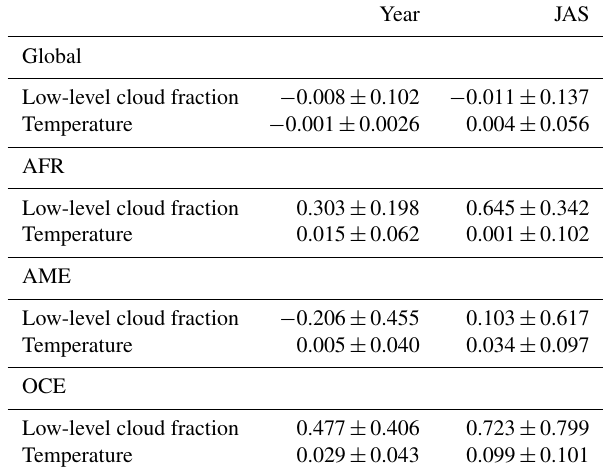
Table 7. Annual and JAS averages ± 2 σ (significance level of 95%) BrC effects (differences between BRC and NOBRC) on low-level cloud fraction (%, relative percentage difference of cloud fraction) and temperature (K, 700hPa) at the global scale and over the AME, AFR, and OCE regions (see Fig. 1 for